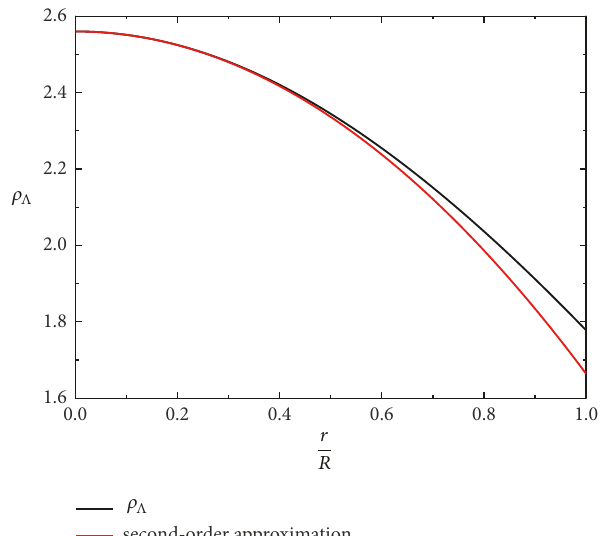
Figure 8: Dark energy density as a function of 𝑟/𝑅 , where 𝑅 is the radius of the star. The upper curve depicts the result of the monopole approximation and the lower curve is an approximation for the upper one. The figure is taken from [35].